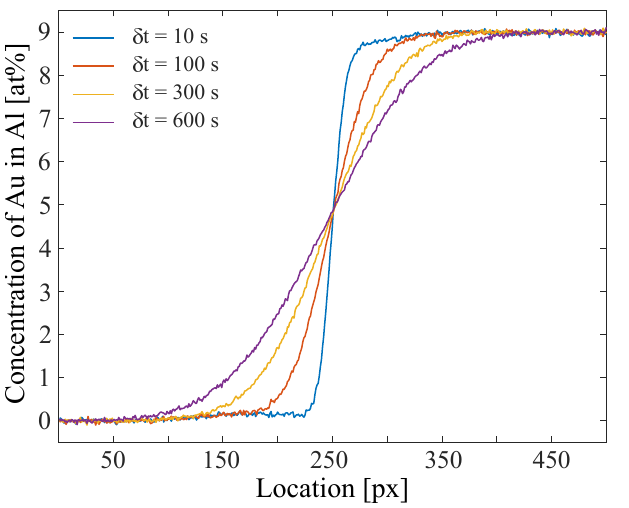
Figure 5. Al–Au concentration profile propagating with time measured using X-ray radiography at 1000 ◦ C. The statistic noise of the data set is ∼